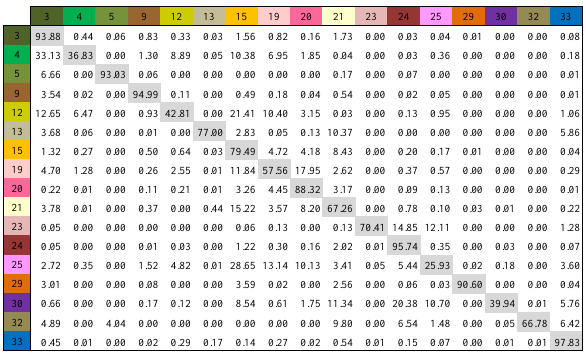
Table 1. Land cover classification system of MapBiomas